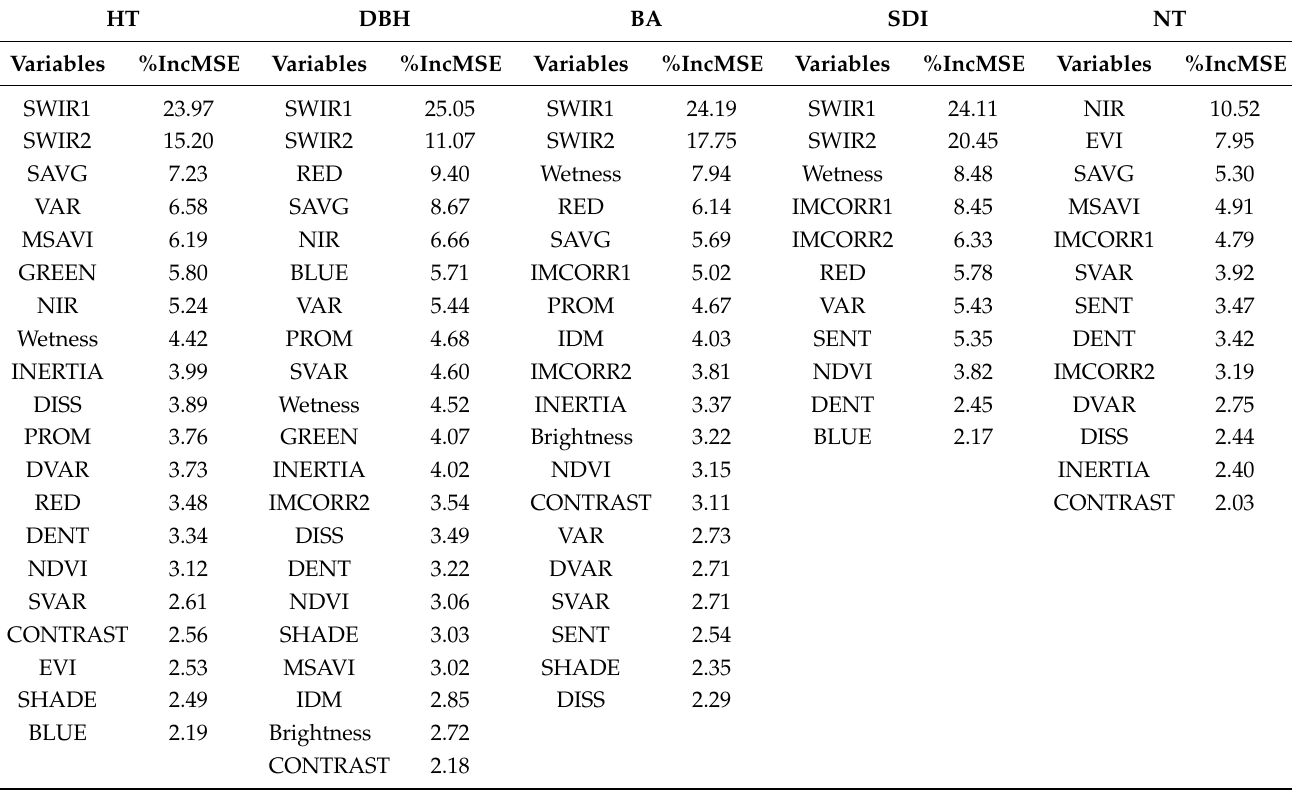
Table 6. Relative importance of predictors with %IncMSE ≥ 2 by random forests models using the training dataset for the 2nd cycle